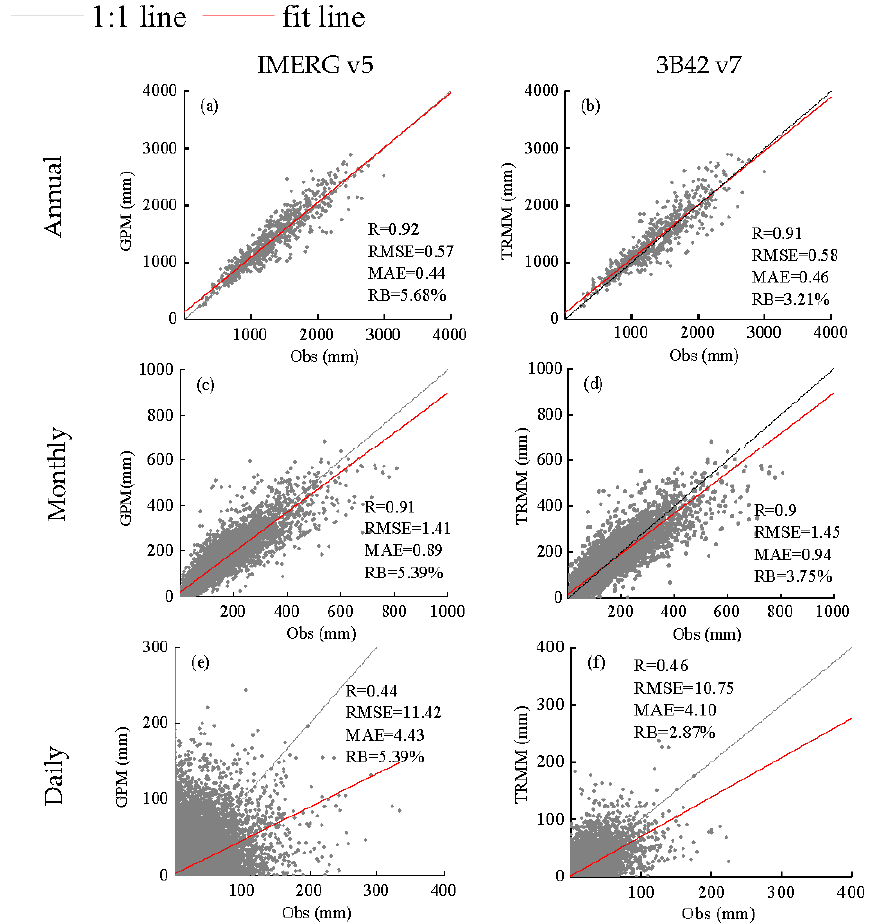
Figure 3. Scatterplots of annual, monthly, and daily precipitation between rain gauge stations and two SPPs. ( a ), ( b ): annual scale; ( c ), ( d ): monthly scale; ( e ), ( f ): daily scale.